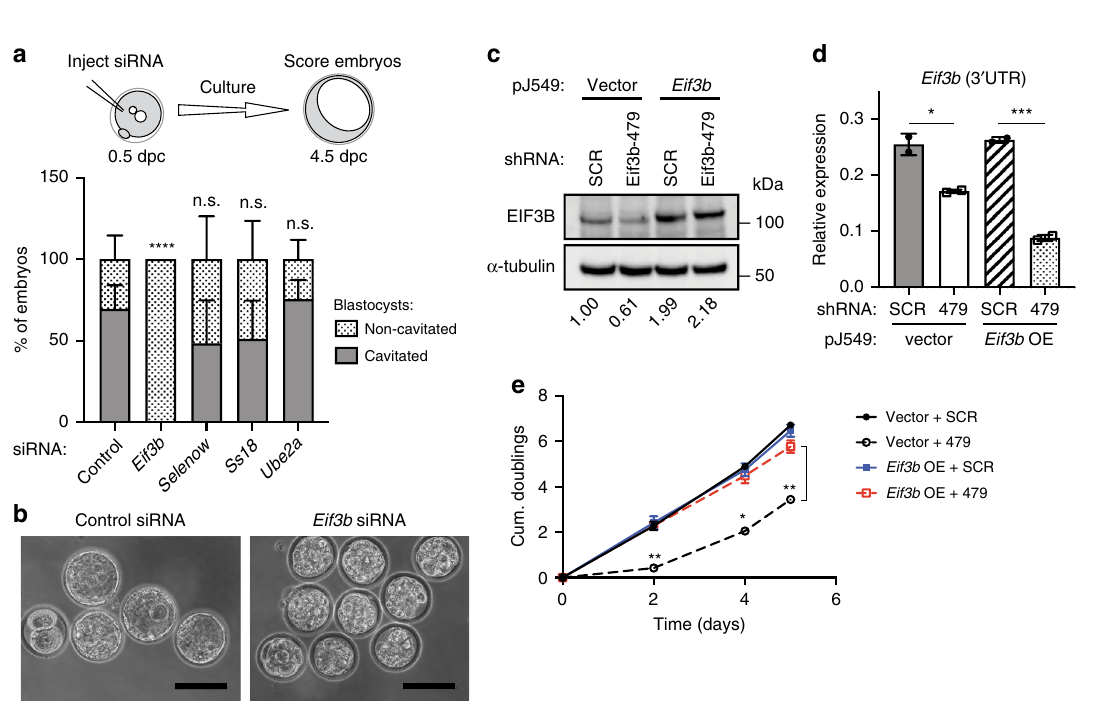
Fig. 4 Loss of EIF3B causes lethality in preimplantation embryos and mESCs. a Eif3b -de fi cient embryos arrest prior to blastocyst formation. Expression of candidate target genes was knocked down in wild-type zygotes by injection of siRNA: control ( n = 38), Eif3b ( n = 40), Selenow ( n = 93), Ss18 ( n = 87), and Ube2a ( n = 66), and blastocyst morphology was scored after 4 days ’ embryo culture. Y -axis: percentage of cavitated or non-cavitated blastocysts of total embryos analyzed in each experiment, for at least 3 independent experiments per target gene. b Representative images of embryos treated with control or Eif3b -targeting siRNA, acquired at 4.5 dpc. Scale bar: 100 μ m. c Western blot analysis of E14 mESCs overexpressing Eif3b or vector control, transduced with indicated shRNA. Numbers in bottom row represent quanti fi cation of relative EIF3B protein levels after background subtraction and normalization to α - tubulin. d qRT-PCR validation of Eif3b knockdown in E14 mESCs transformed with vector control (vector) or Eif3b overexpression construct ( Eif3b OE) and transduced with shRNA targeting the 3 ′ UTR of Eif3b (shRNA-479). 3 ′ UTR-speci fi c primers were used to detect endogenous Eif3b transcript. n = 2 samples, data shown from one out of three independent experiments with similar results. e E14 mESCs transduced with shRNA-479 to deplete endogenous Eif3b exhibit slower growth (vector + 479; black dashed line), while expression of shRNA-resistant Eif3b restores normal growth ( Eif3b OE + 479; red dashed line). Cells were plated at equal densities, passaged at Day 2 and Day 4, and counted at indicated time-points. n = 3 replicates, representative data shown (from same experiment as in Fig. 4d). Error bars denote mean ± s.d.; * P < 0.05, ** P < 0.01, *** P < 0.001, **** P < 0.0001, n.s., not signi fi cant; two-tailed unpaired Student ’ s t test ( a and d ), two-way ANOVA with Tukey ’ s multiple comparisons test ( e